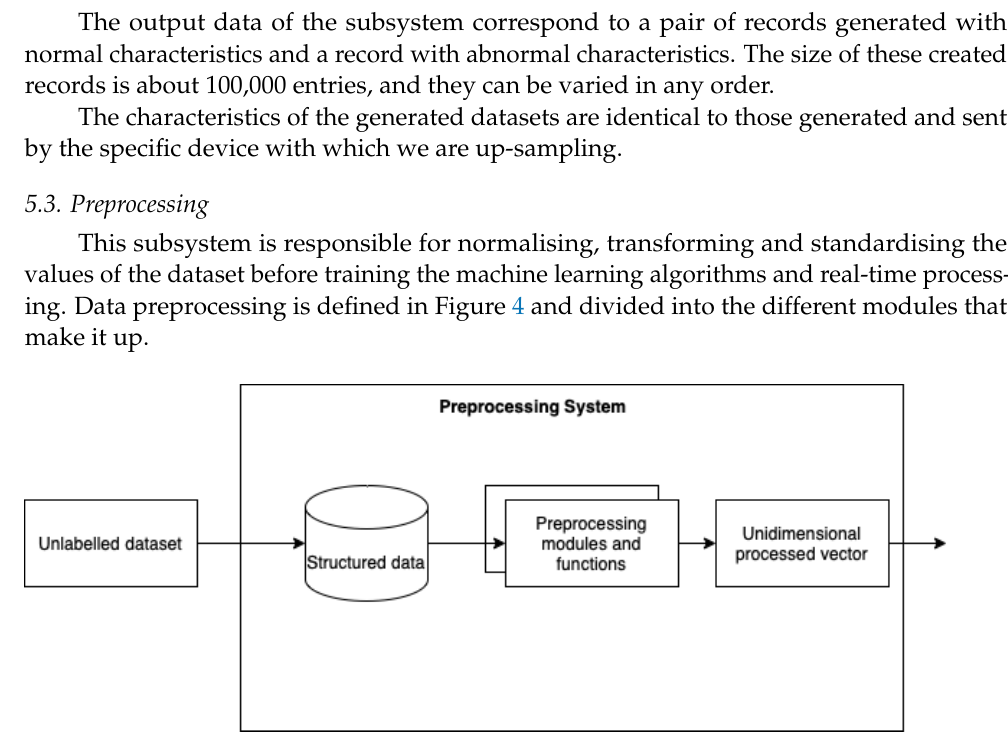
Figure 4. Modular architecture of the preprocessing